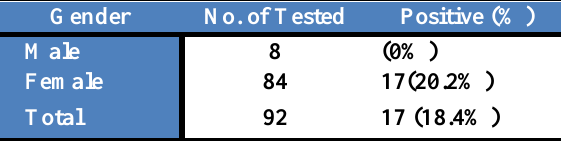
Table, 2: Prevalence of T.gondii in horses by using ELISA according to Gender.